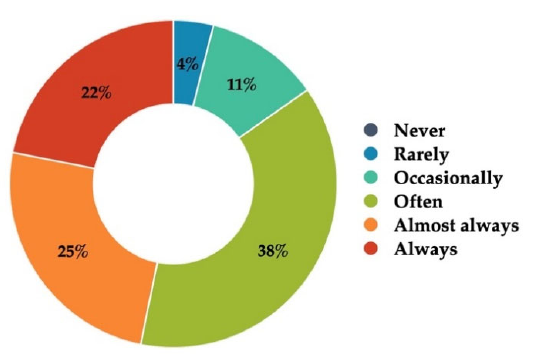
Figure 6. How often you check email and/or social media before doing other things.